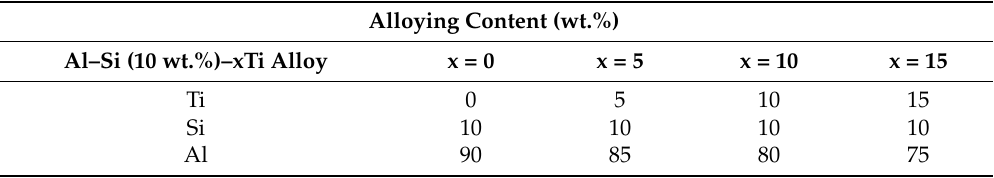
Table 1. Ingredients of various